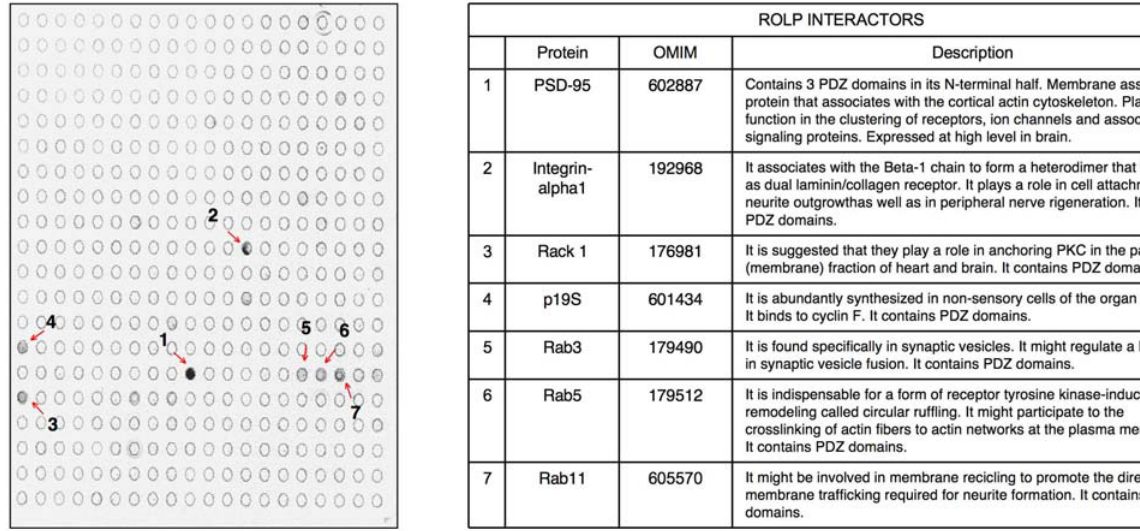
Figure 2. Antibody array analysis. The immunodetection with digoxigenin-labelled ROLP-specific IgGs revealed positive in several spots: PSD-95 (1), Integrin-alpha1 (2), Rack 1 (3), p19Skp1 (4), Rab3 (5), Rab5 (6), Rab11 (7). The OMIM code of each gene is reported together with the correspondent gene